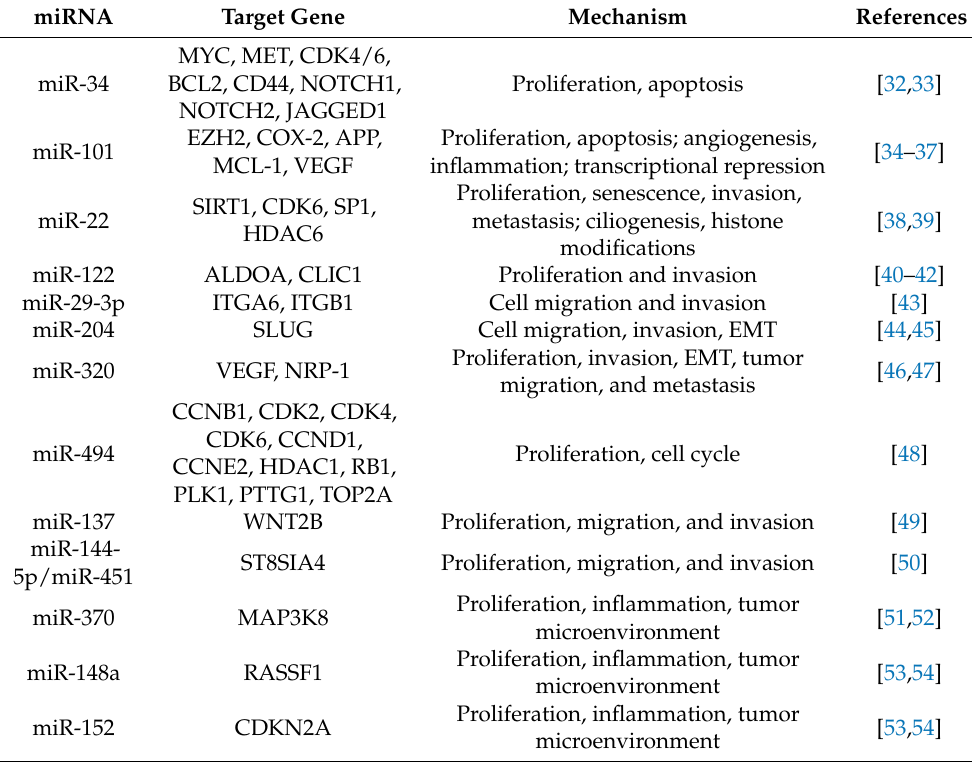
Table 2. MiRNAs acting as oncosuppressor-miRNAs in BDC: their targets and molecular function. miRNA Target Gene